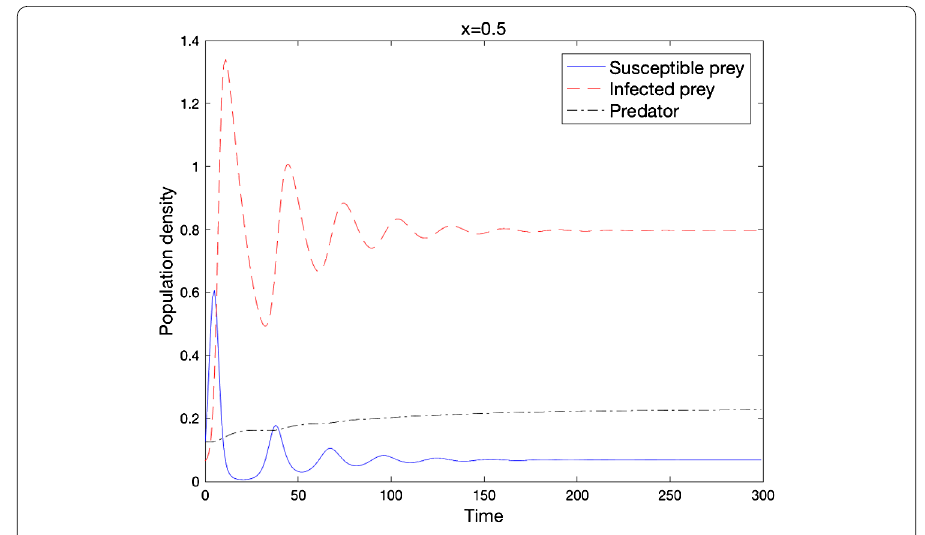
Figure 5 Local stability of u ∗ when the condition of Theorem 2.11 holds ( d = 0.01, D = 0.01, r = 0.3699, b = 0.430, d 1 = 0.0291, d 2 = 0.0069, K = 0.9299, α = 0.0122, β = α , c = 8.0999, m =